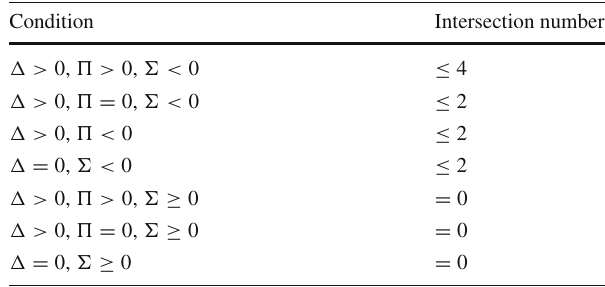
Table 1 Constraints on the intersection number for the critical point φ